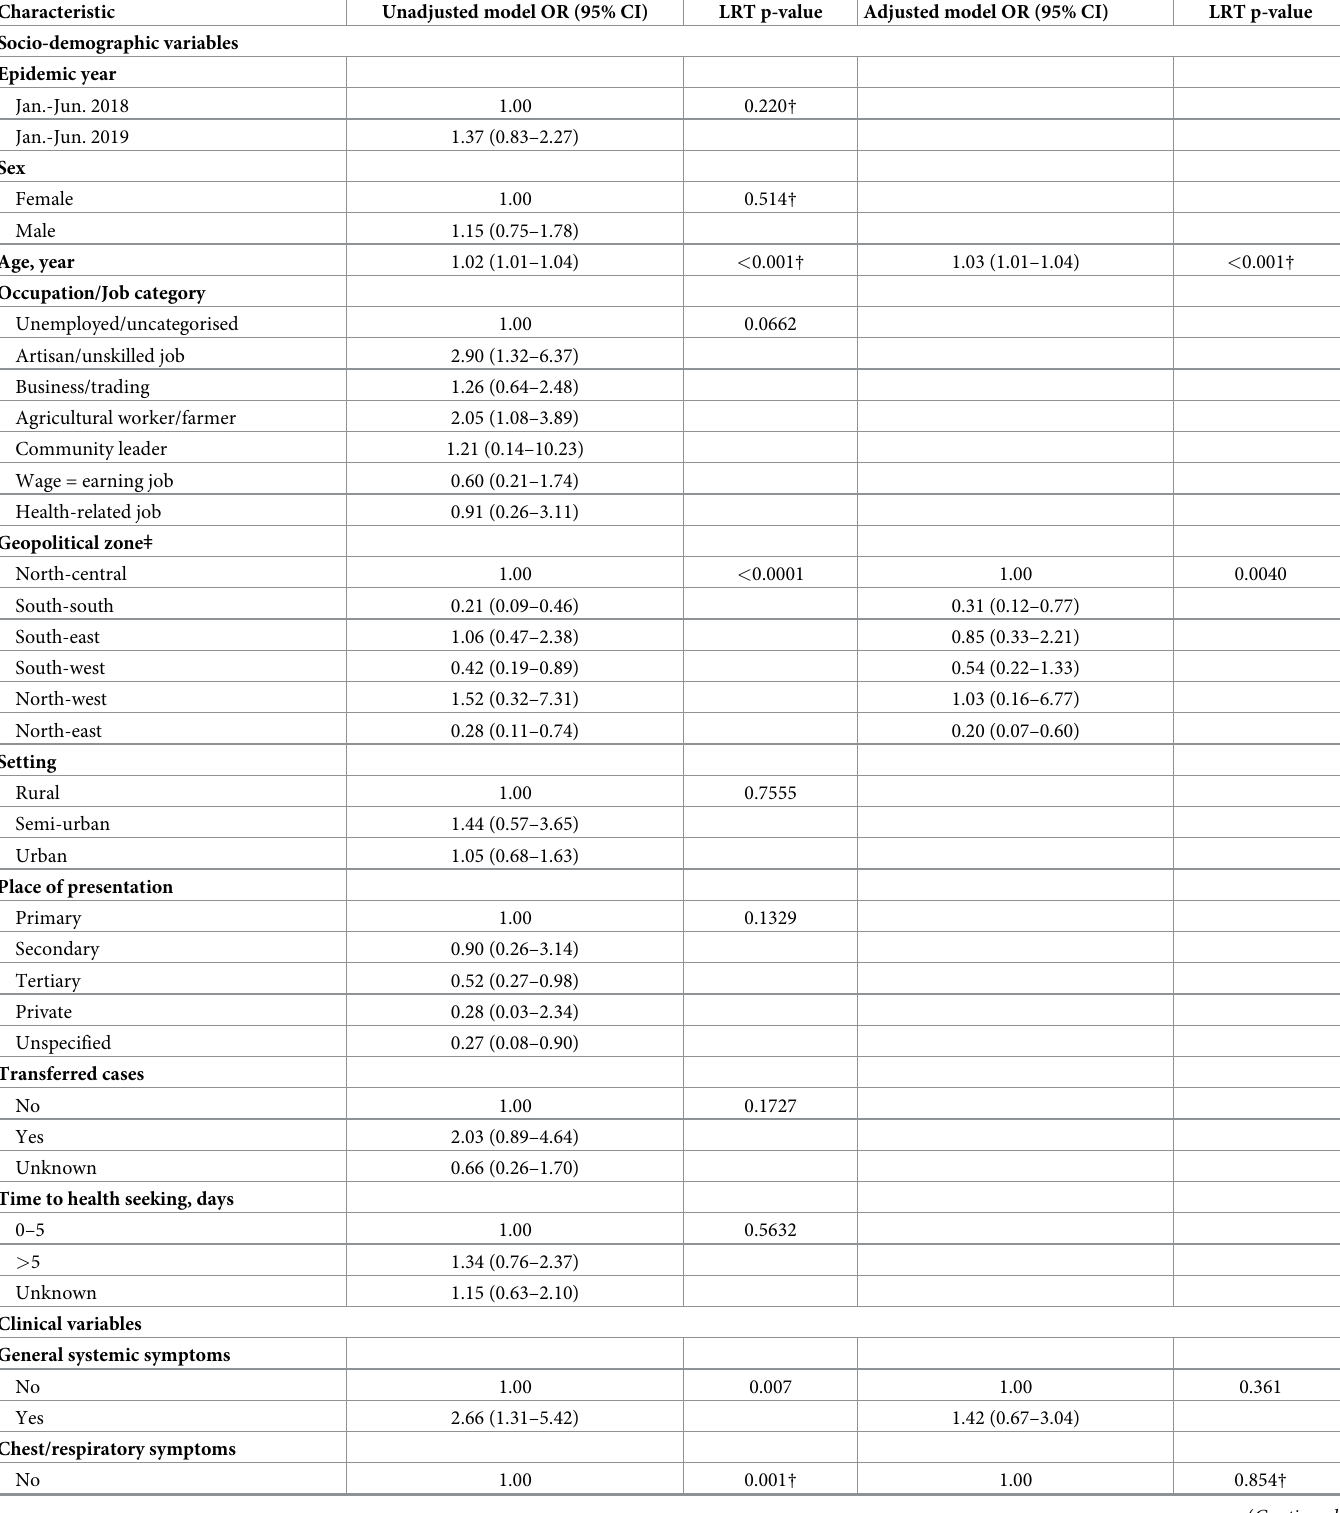
Table 5. Logistic regression results of socio-demographic and clinical factors associated with death among Lassa fever patients (N =